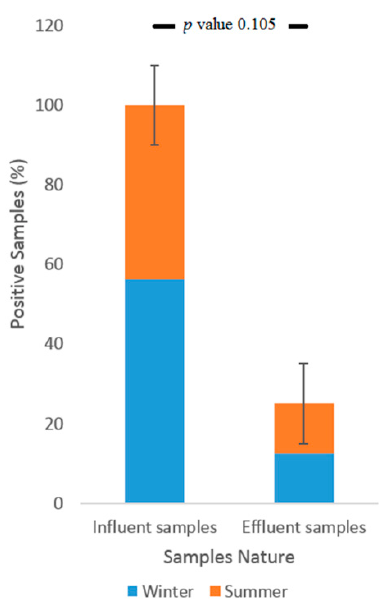
Figure 6. Comparisons of detection frequencies (%) of enteric viruses during summer and winter seasons.